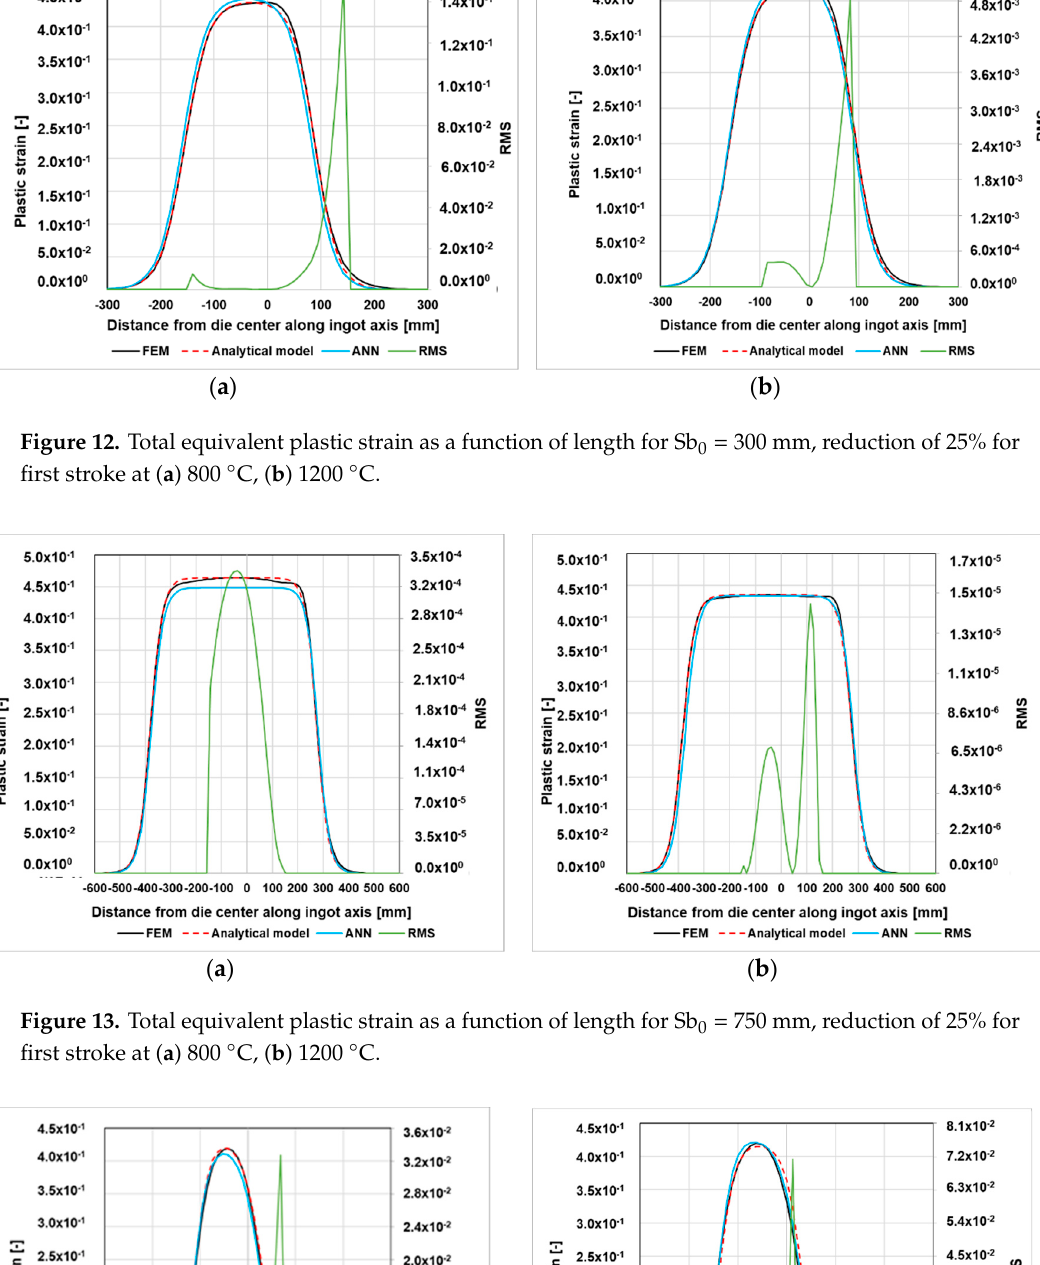
Figure 11. 42CrMo4. Flow stress curves by hot forming. Figure 5.309 in [44].